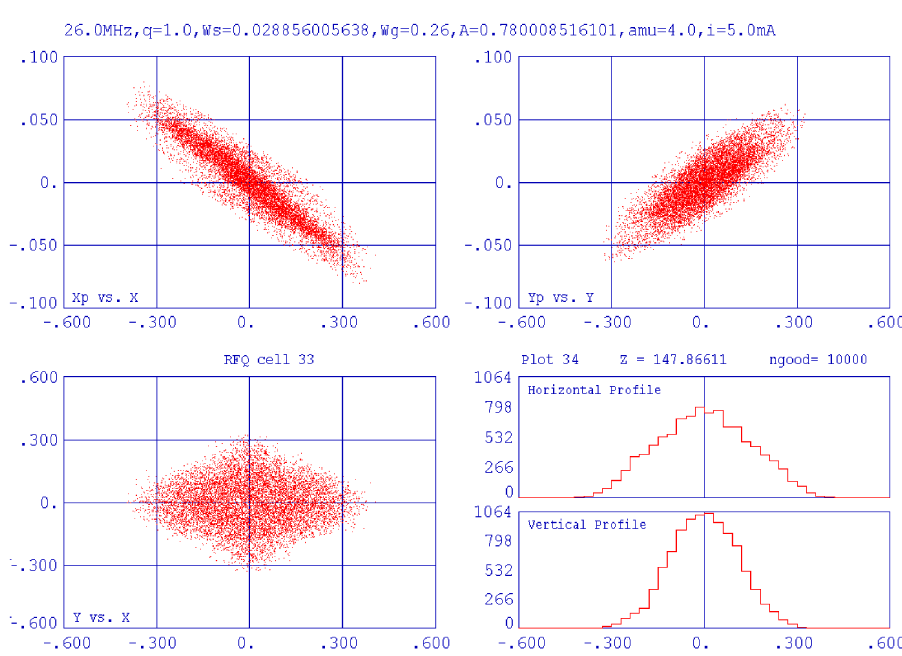
FIG. 8. Output beam distributions at the end of the 33rd cell of the RFQ. The output beam distribution in phase space and the optimized RFQ parameters such as the modulation m and the synchronous phase (cid:6) s , are plotted in Figs. 8 and 9,